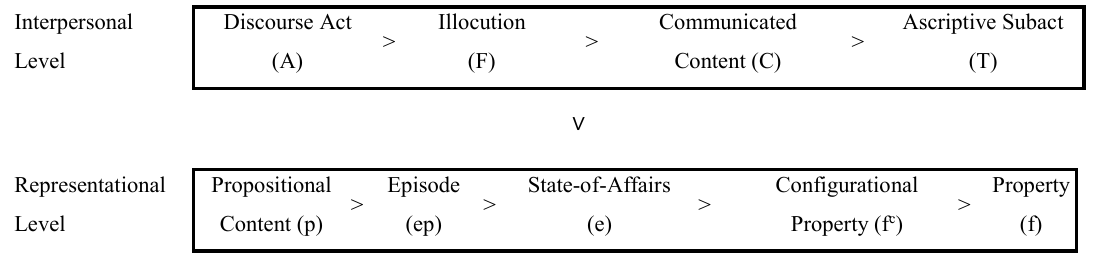
Figure 1. Scope relations in